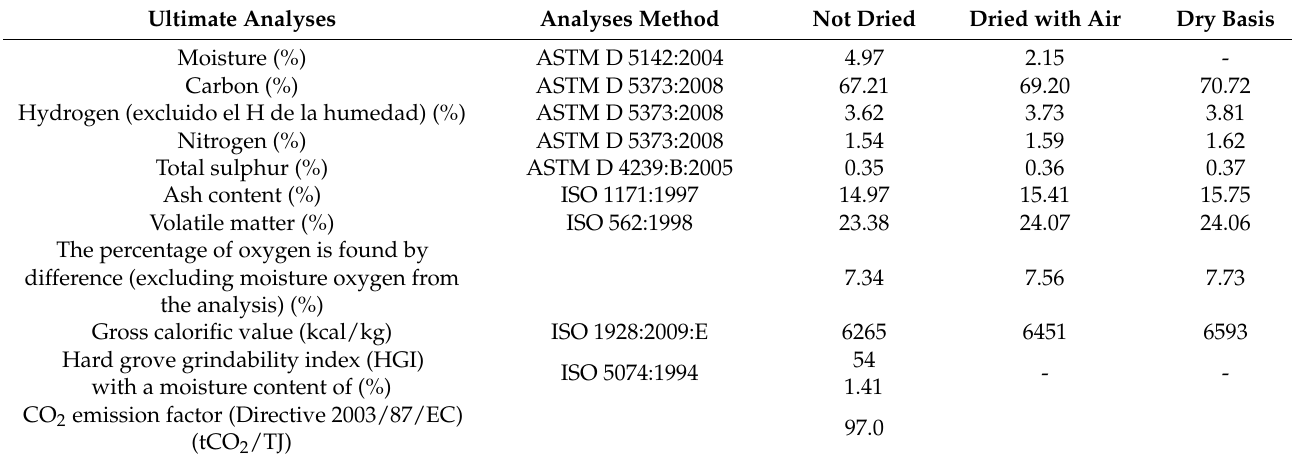
Table 2. South African coal